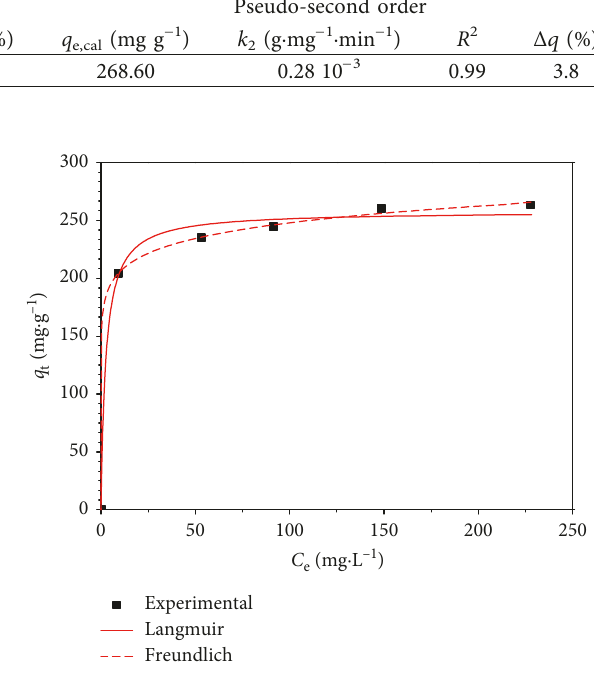
Figure 11: Nonlinear fits of the Langmuir and Freundlich iso- therms for methylene blue adsorption onto activated Table 6: Langmuir and Freundlich isotherm parameters at 20 ° C.